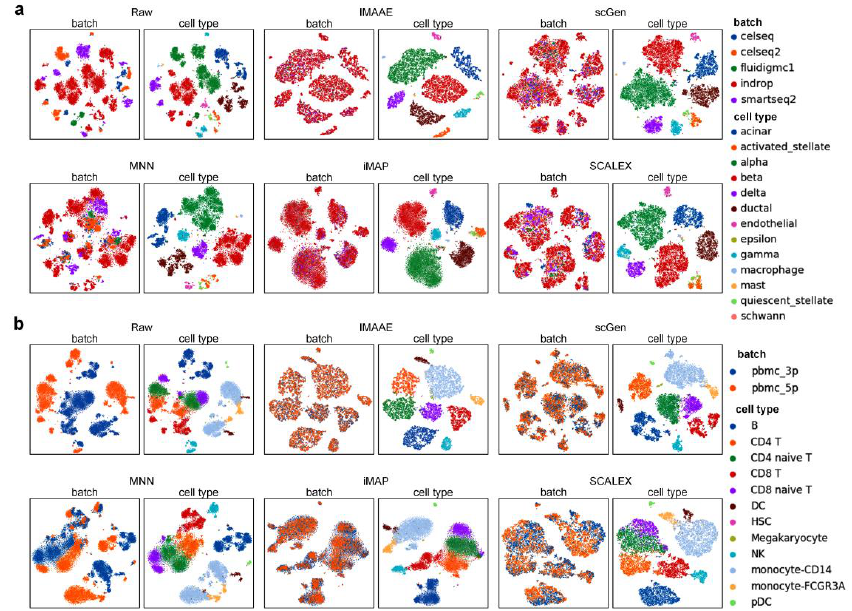
Figure 5. Qualitative evaluation of each batch correction method using t-SNE visualization on ( a ) Pancreas dataset and ( b ) PBMC dataset. Each method contains two T-SNE plots. On the left, coloring by batch type, and on the right, coloring by cell type.